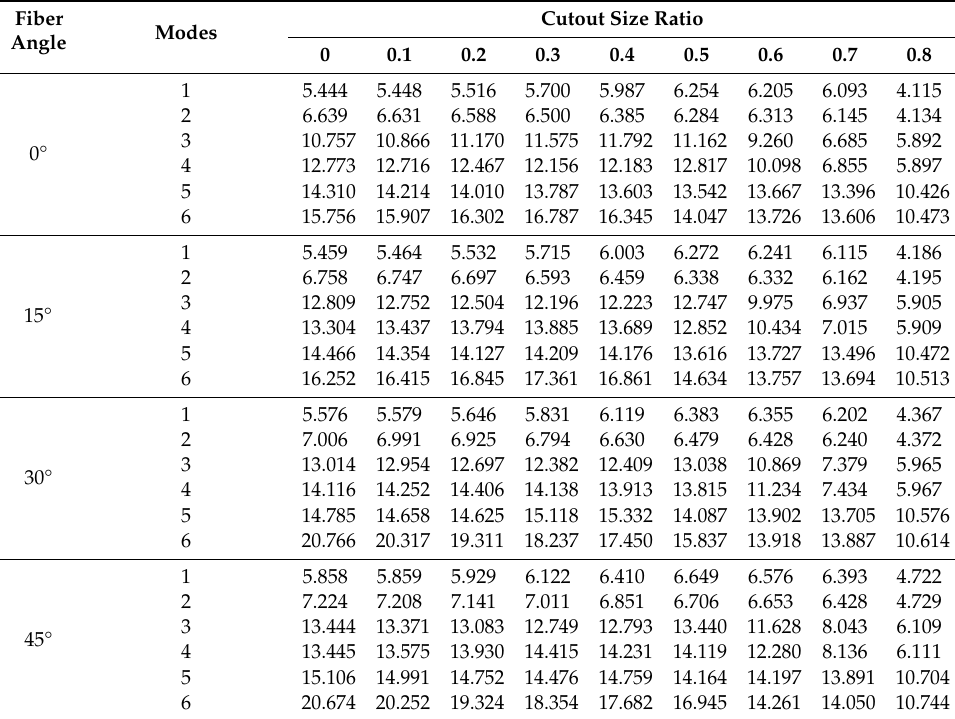
Table A2. First six frequency parameters Ω of angle-ply (0 ◦ / ϑ ◦ / 0 ◦ ) square plate with various fiber direction angle varied from 0 ◦ to 180 ◦ under CFCF boundary